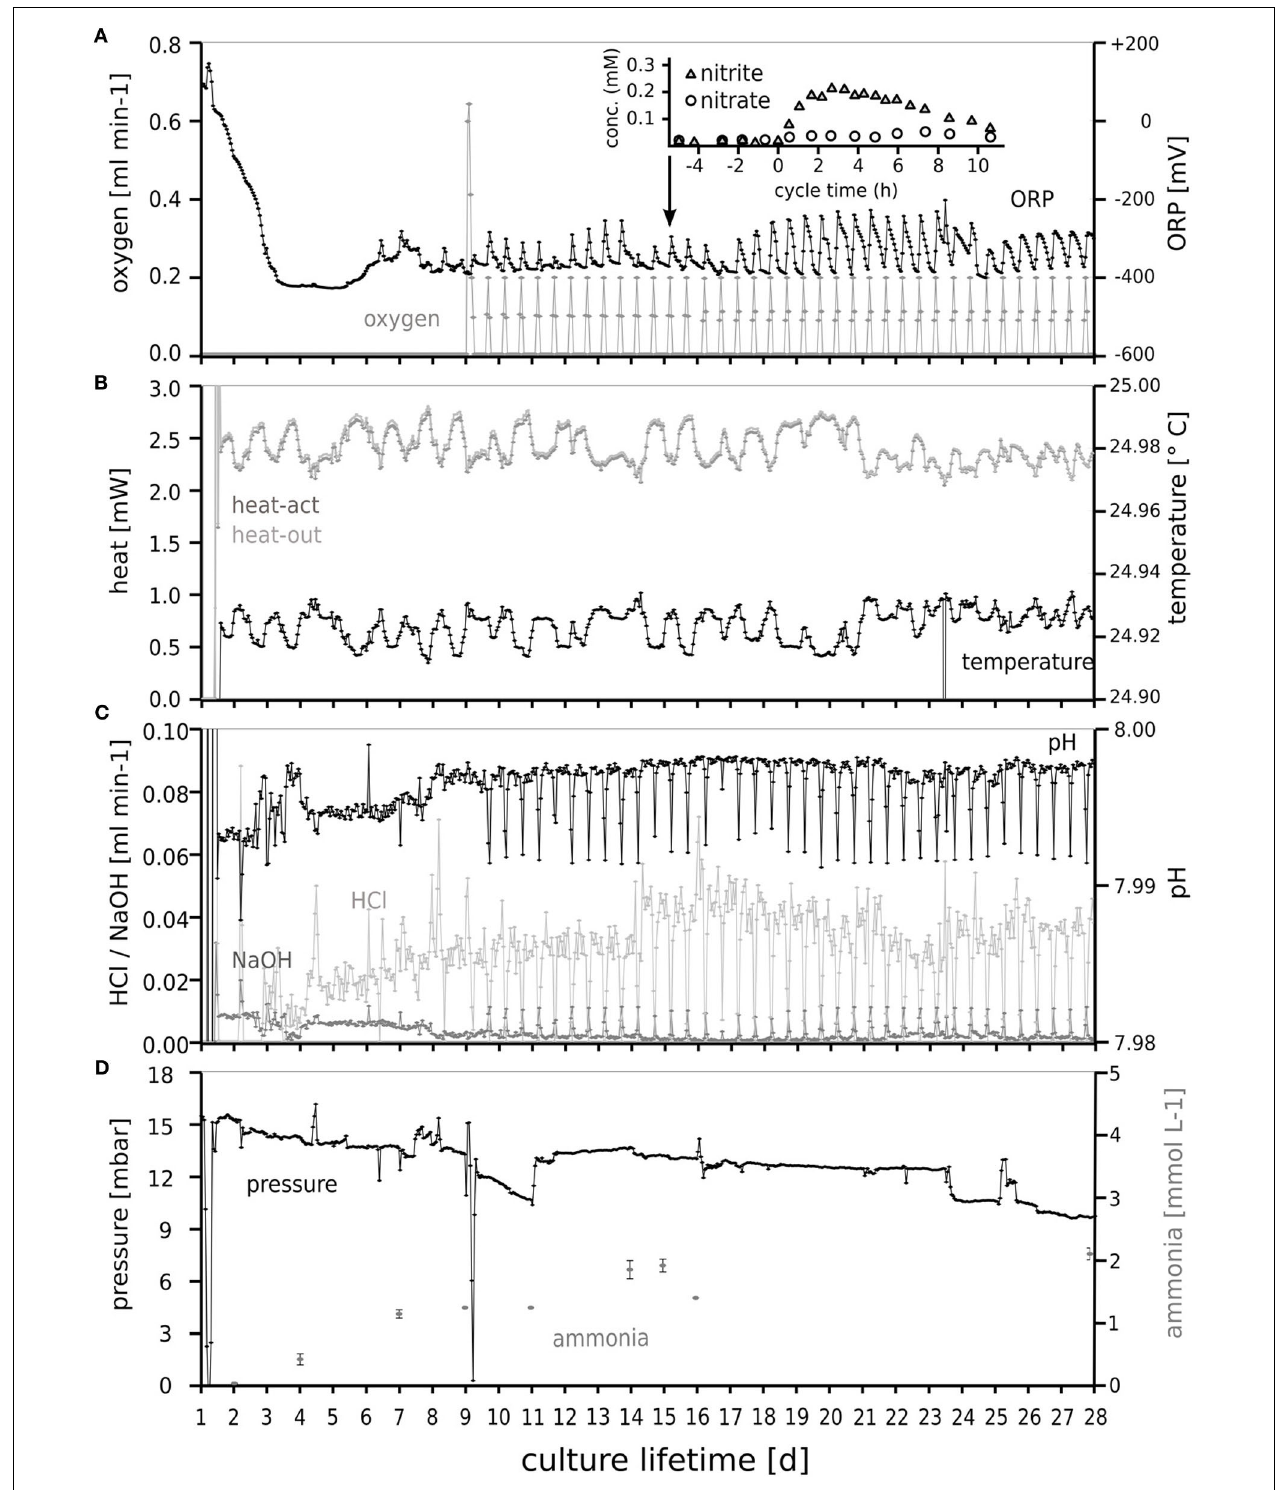
FIGURE 2 | Oxygen dosage (A), temperature and heater power (B), and pH control (C) enabling dynamic “tidal” conditions for selection of the microbial community in the chemostat during 28 days. The response of the culture to the intermittent oxygen supply is clearly visible in the redox sensor ( A , ORP) response. The